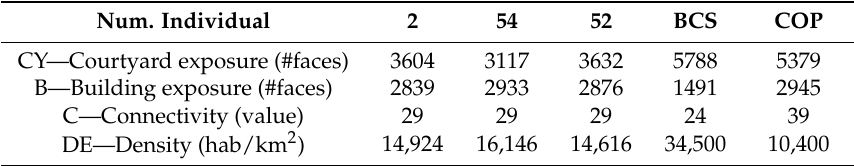
Table 4. Selected individuals based on Relative Difference compared to current and original state. Num.